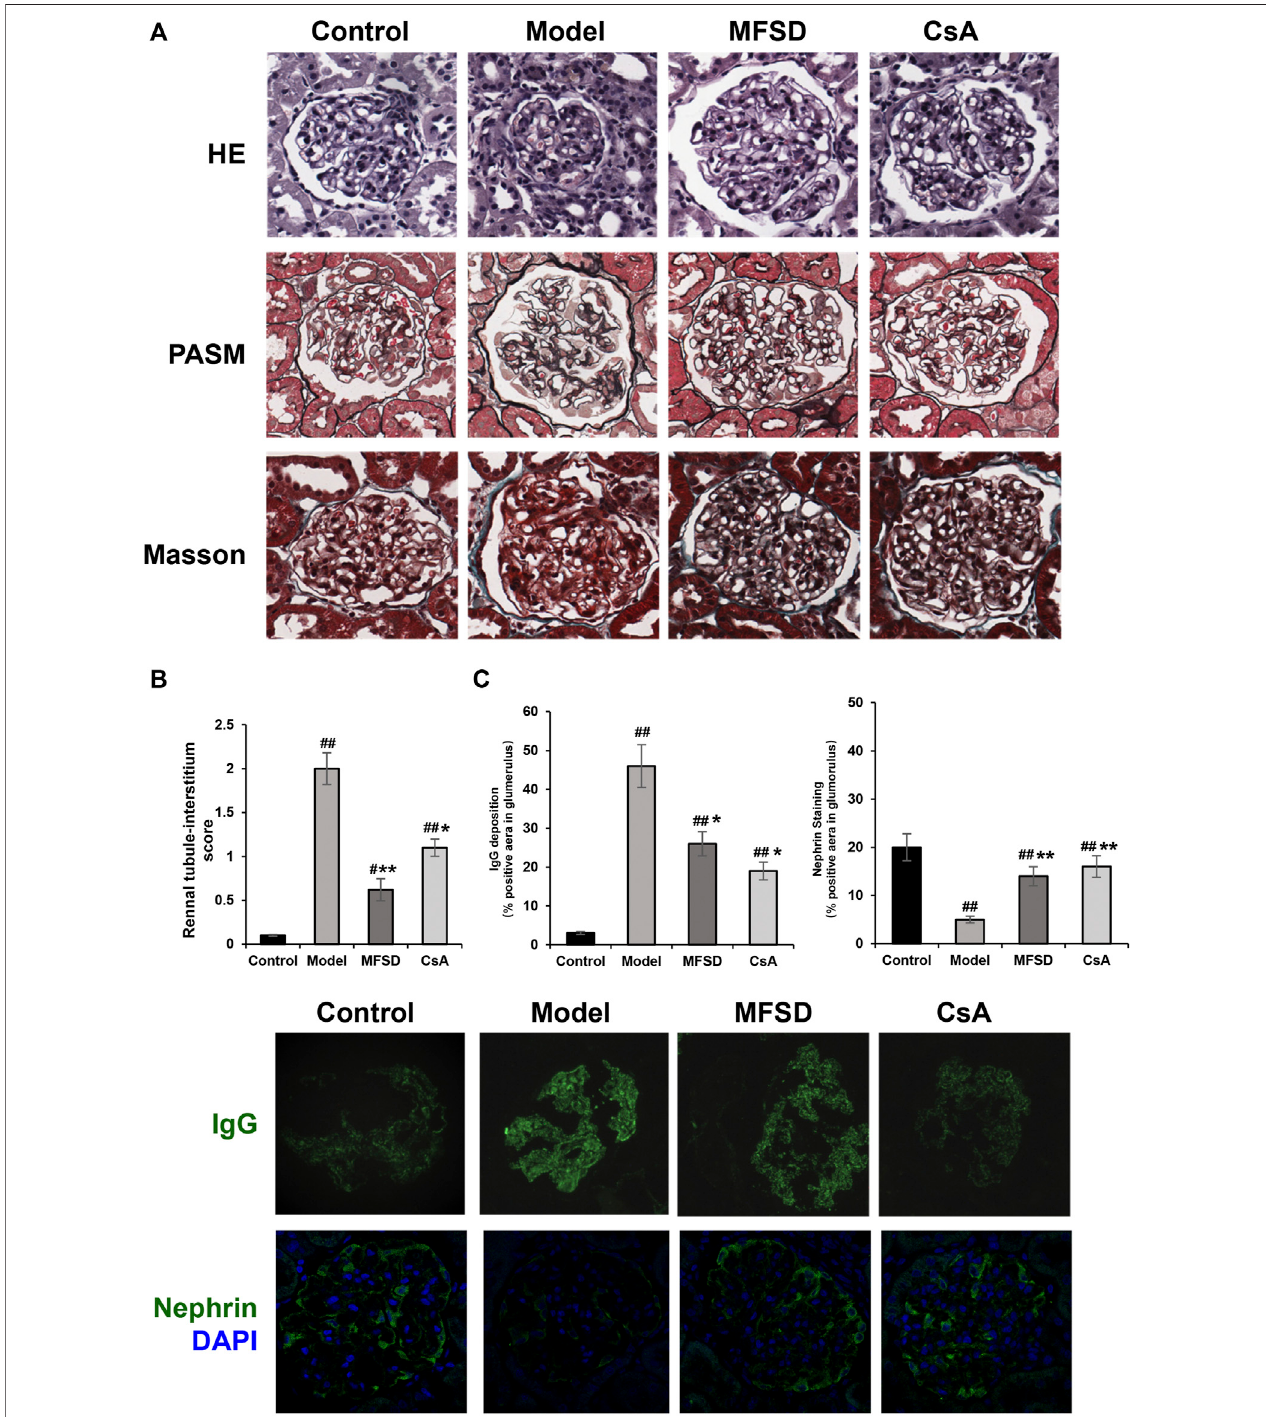
FIGURE2| MFSDamelioratedglomerularpathomorphologicalandpodocyteinjuriesinPHNrats .(A) Representativerenalpathologicalstainingimagesofdifferent groups. Top, the images ofrenal tissuesbyHE stainingwere obtainedunder alightmicroscope (×400 magni fi cation) (scale bar =20 μ m), Middle and bottom, images of renal tissues by PASM staining and Masson staining were obtained under a light microscope (×400 magni fi cation) (scale bar = 20 μ m) (B) Histogram is the statistical results of renal tubule-interstitium score of different groups; (C) Representative images of IgG and nephrin were observed under a confocal microscope at ×400 magni fi cation (scale bar = 20 μ